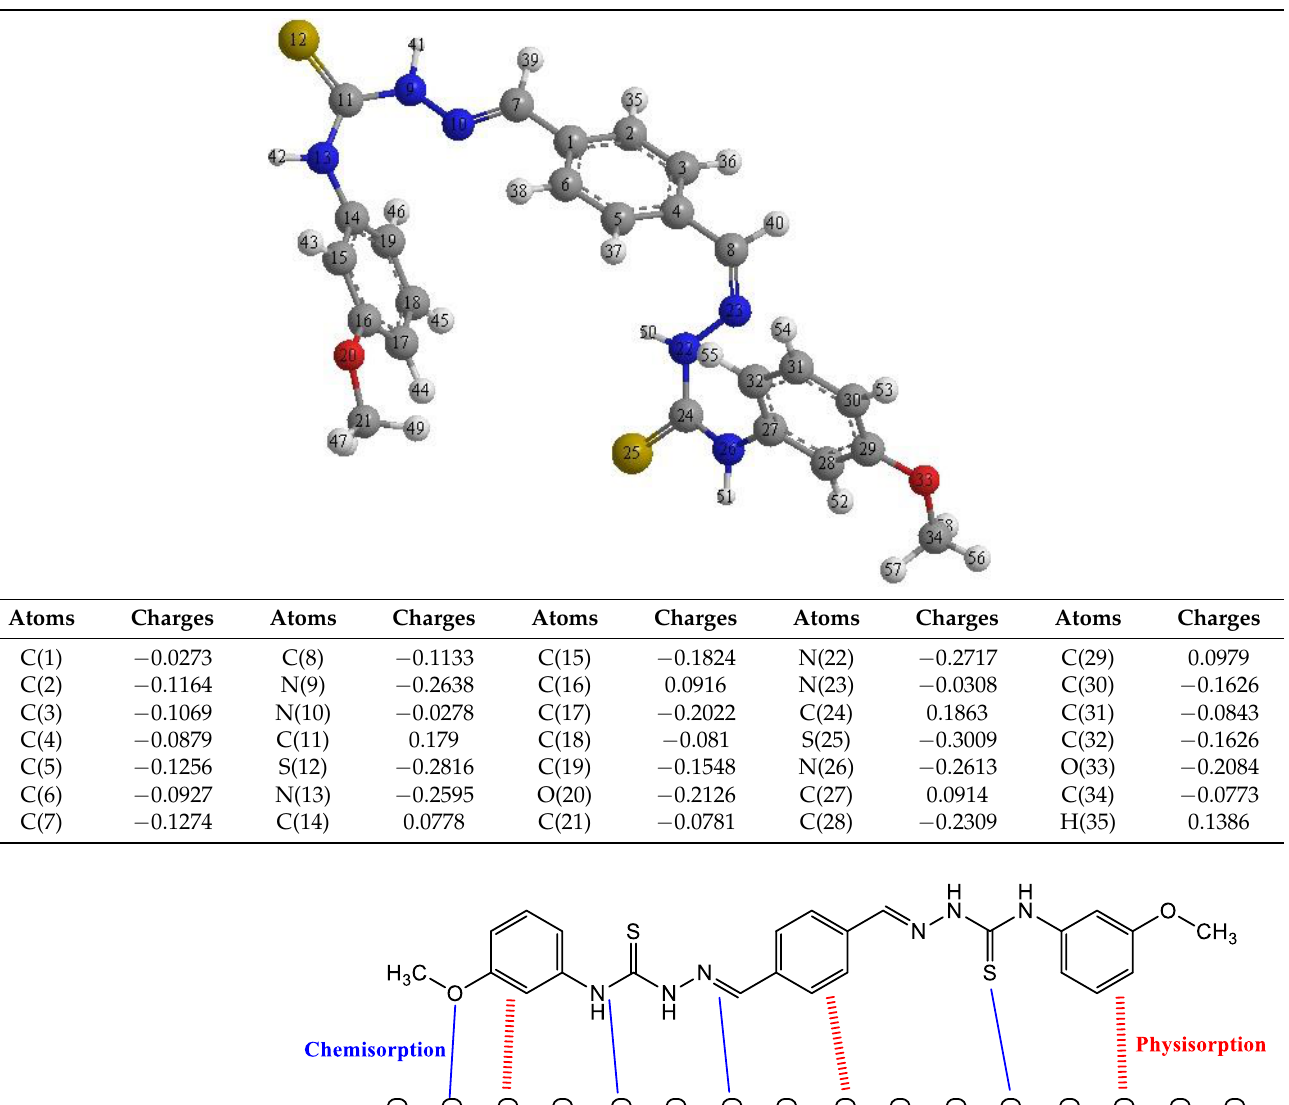
Table 6. Mulliken charges of tested inhibitor molecules.